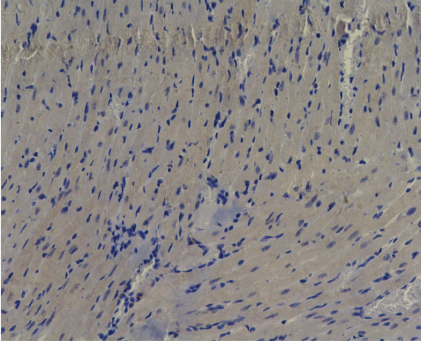
Figure 6: Baicalin-treated group-3h TUNEL × 200 (negtive ex-